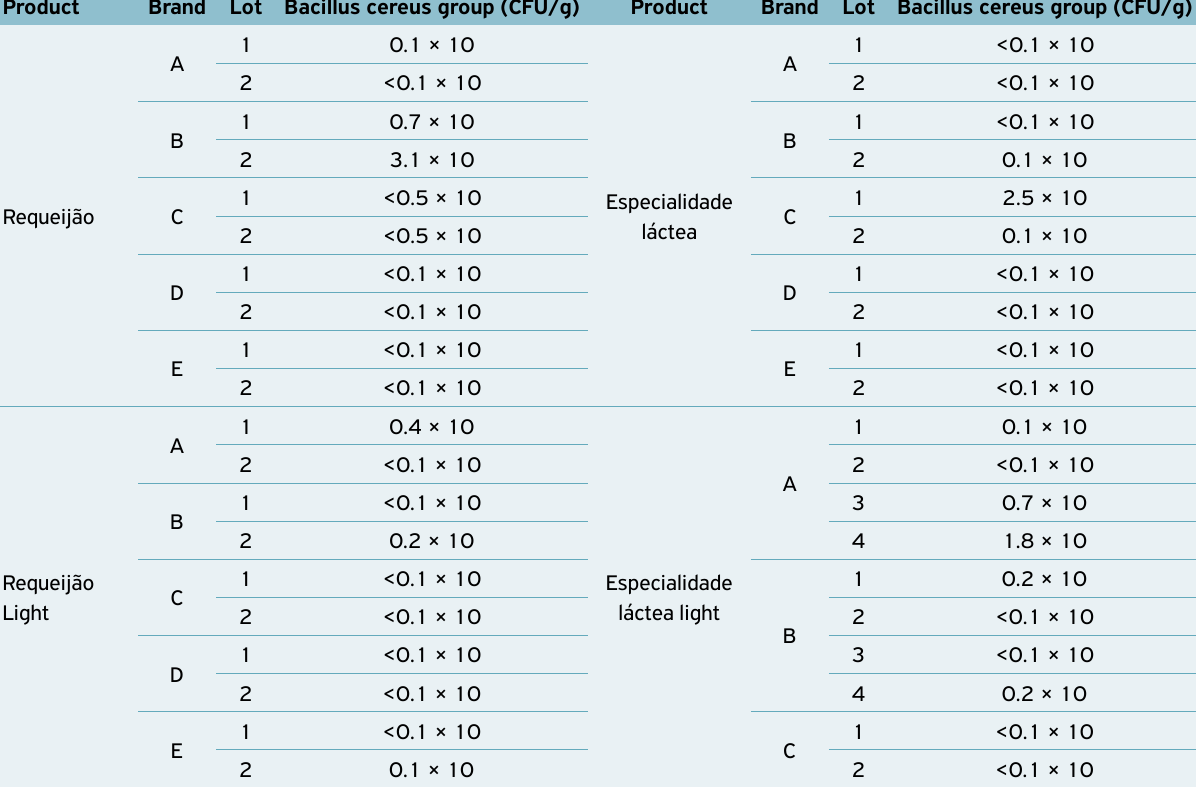
Table 1. Average counts of bacteria from B. cereus group on requeijão , requeijão light , especialidade láctea tipo requeijão